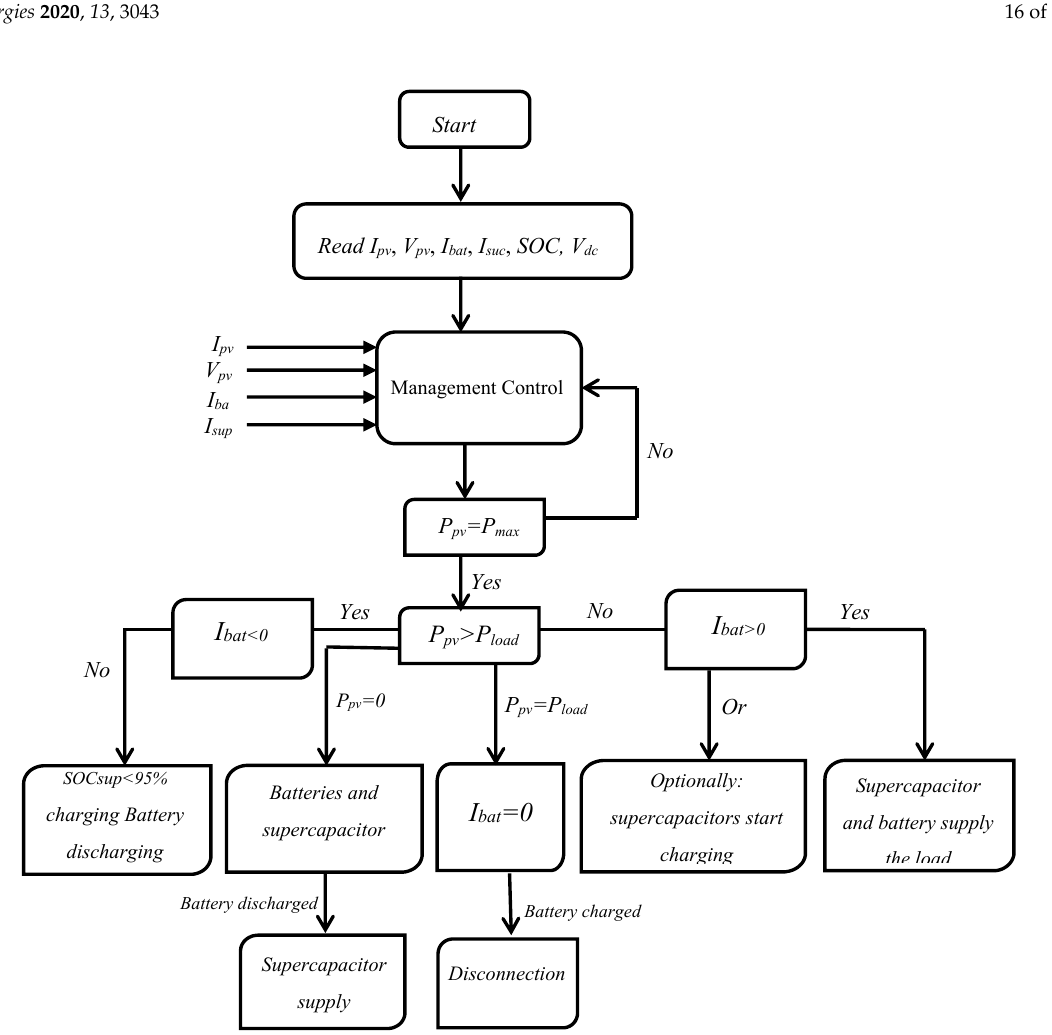
Figure 10. Overview in the energy management flowchart.